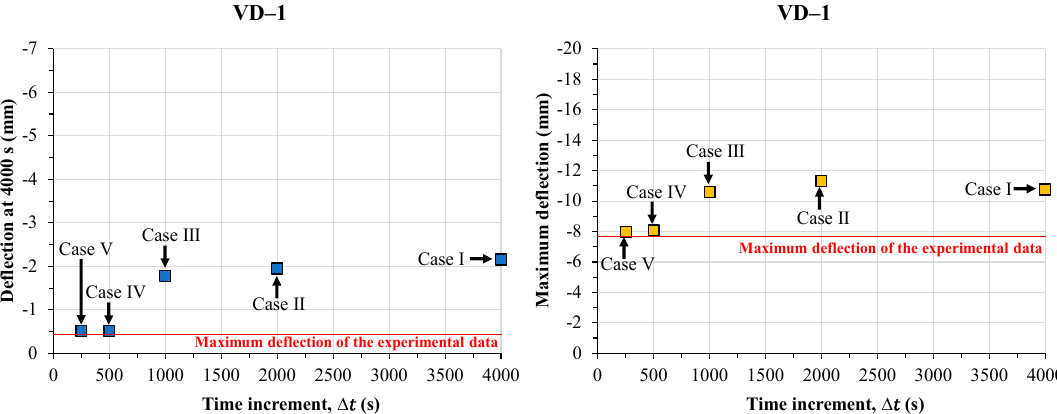
Figure 22. Displacement over time at VD-3.